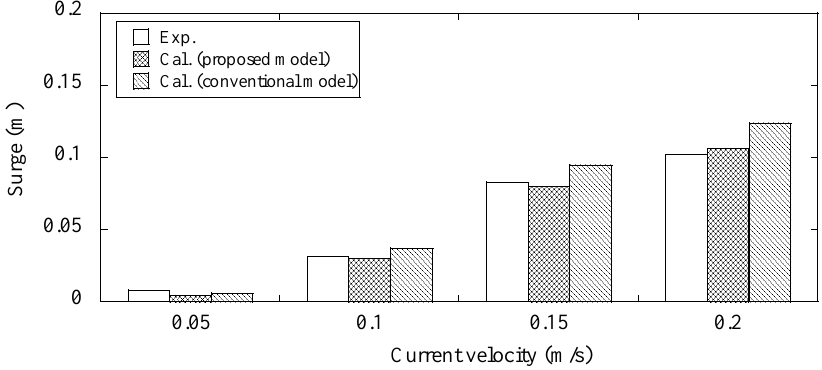
Figure 10. Comparison of predicted and measured surge displacement in the current-only condition.